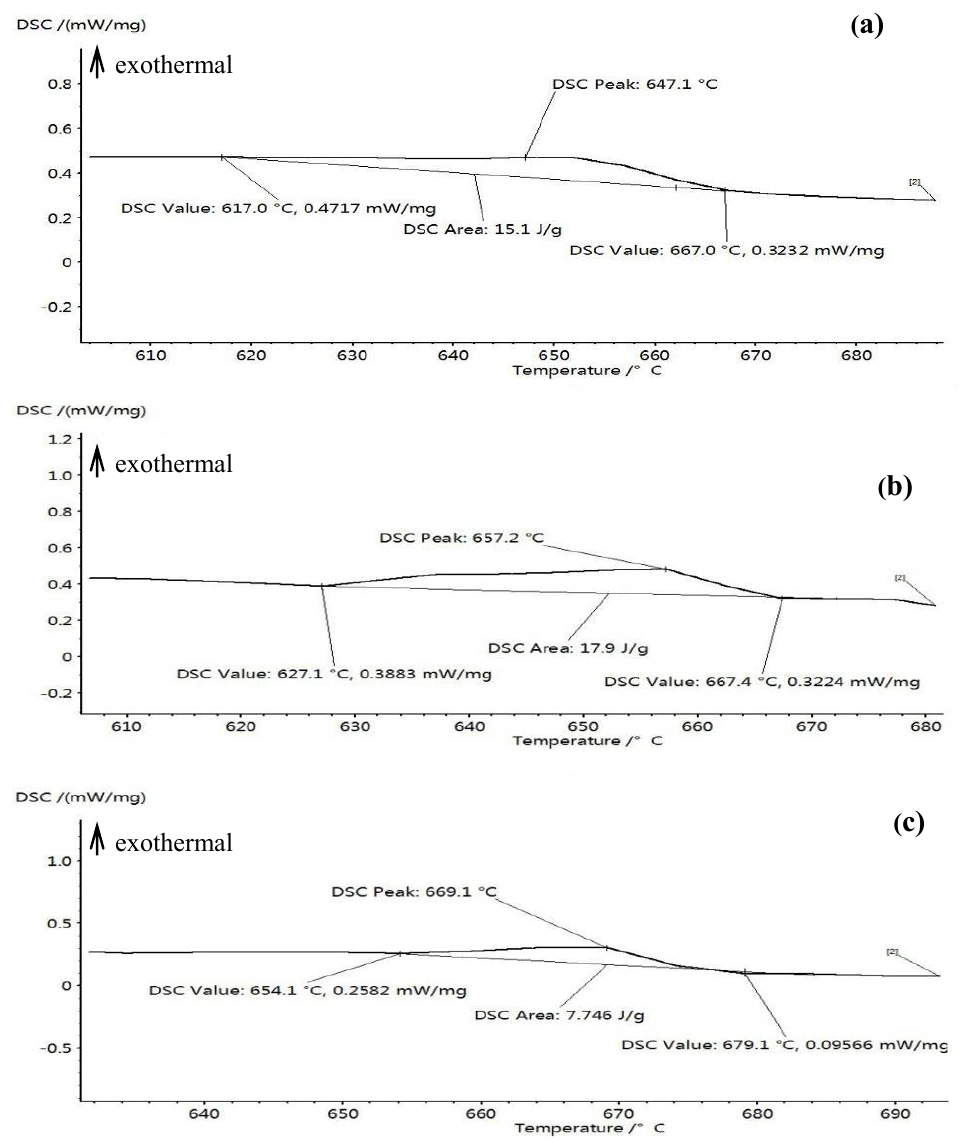
Figure 14. Part of the cooling process DSC curves between 700–600 °C: ( a ) unmodified alloys; ( b ) 10% FSM master alloy addition prepared by water-cooled copper mold; ( c ) 10%